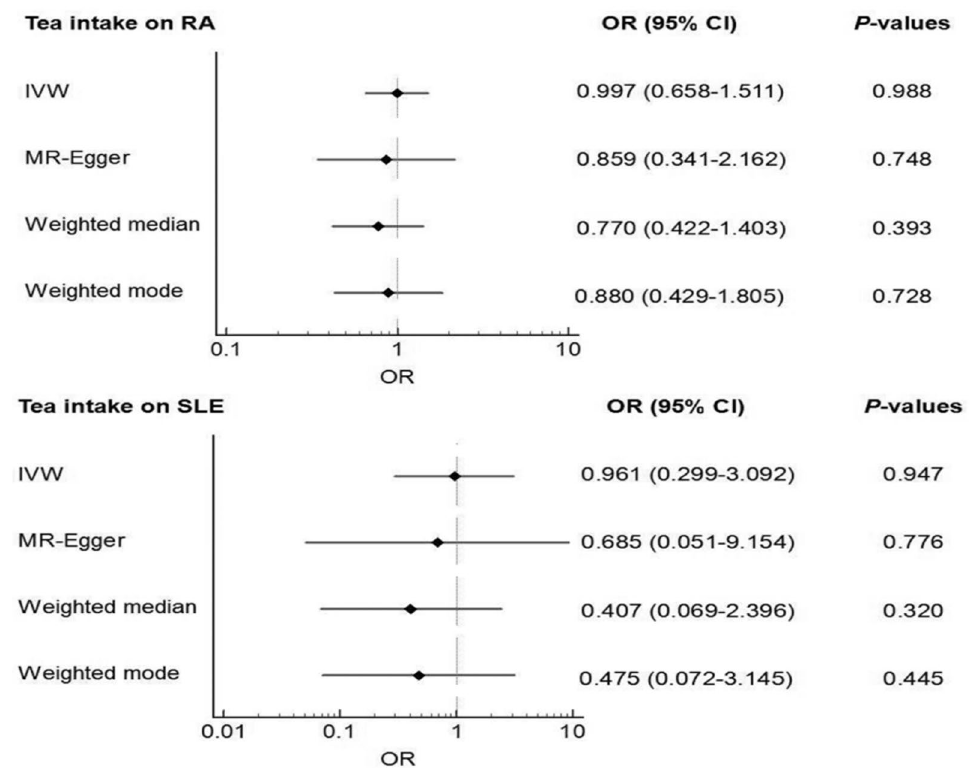
Fig. 1 Univariable Mendelian randomization analyses for the association of genetically instrumented tea intake with RA and SLE. CI, confidence interval; IVW, inverse‑variance weighted; OR, odds ratio; RA, rheumatoid arthritis; SLE, systemic lupus